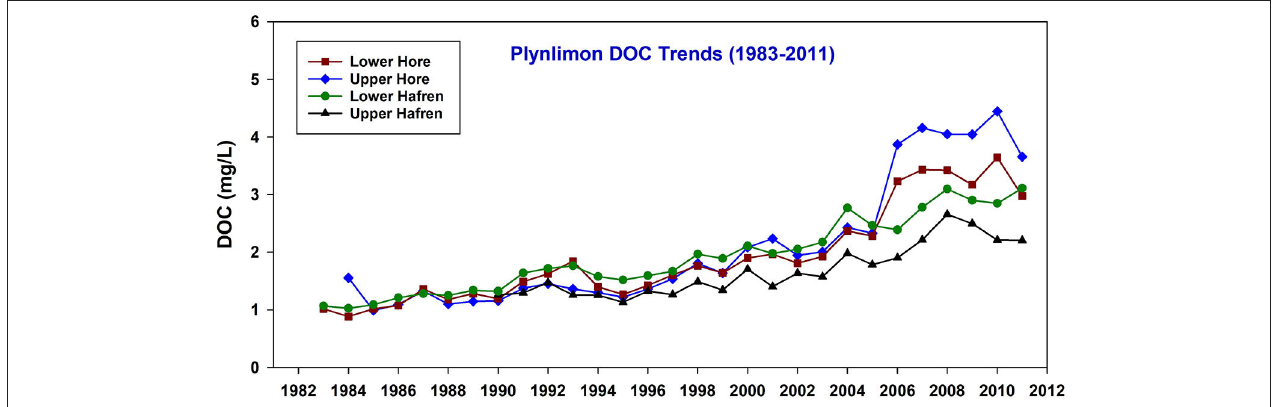
TABLE 1 | Plynlimon Mean, Maximum and Minimum DOC concentrations mg/L (1983–2011).